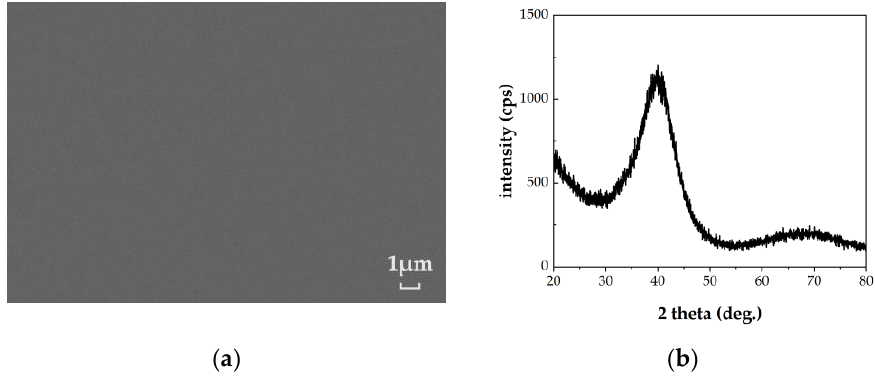
Figure 3. ( a ) The SEM image and ( b ) the XRD pattern of the sample prepared by magnetron sputtering.